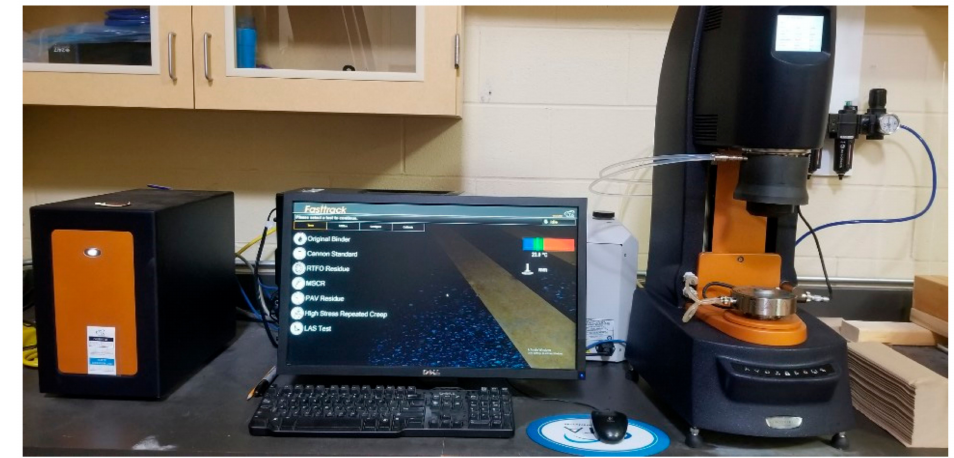
Figure 2. Dynamic shear rheometer (DSR) tester.